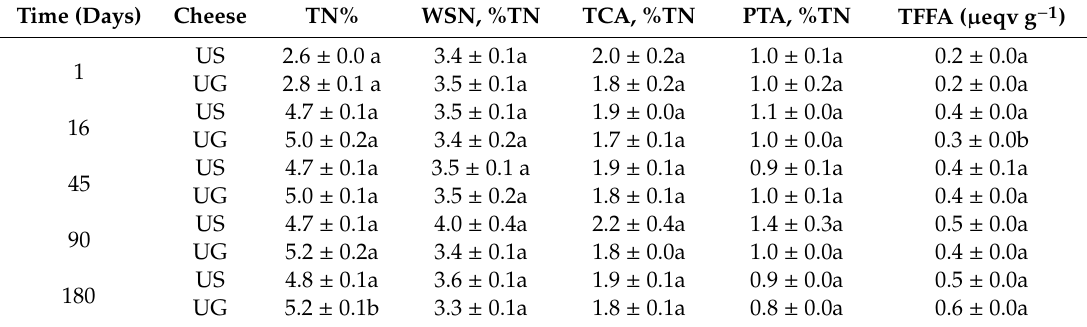
Table 7. Changes of total nitrogen, soluble nitrogenous fractions and total free fatty acid content of Urda cheese made from 100% sheep (US) or a mixture of 90% sheep–10% goat (UG) whey during ripening and